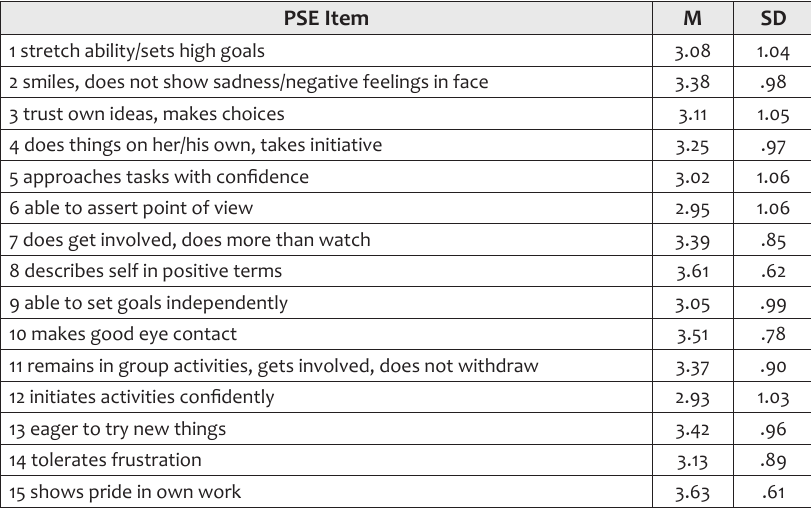
Table1: Means (M) and Standard Deviations (SD) for PSE